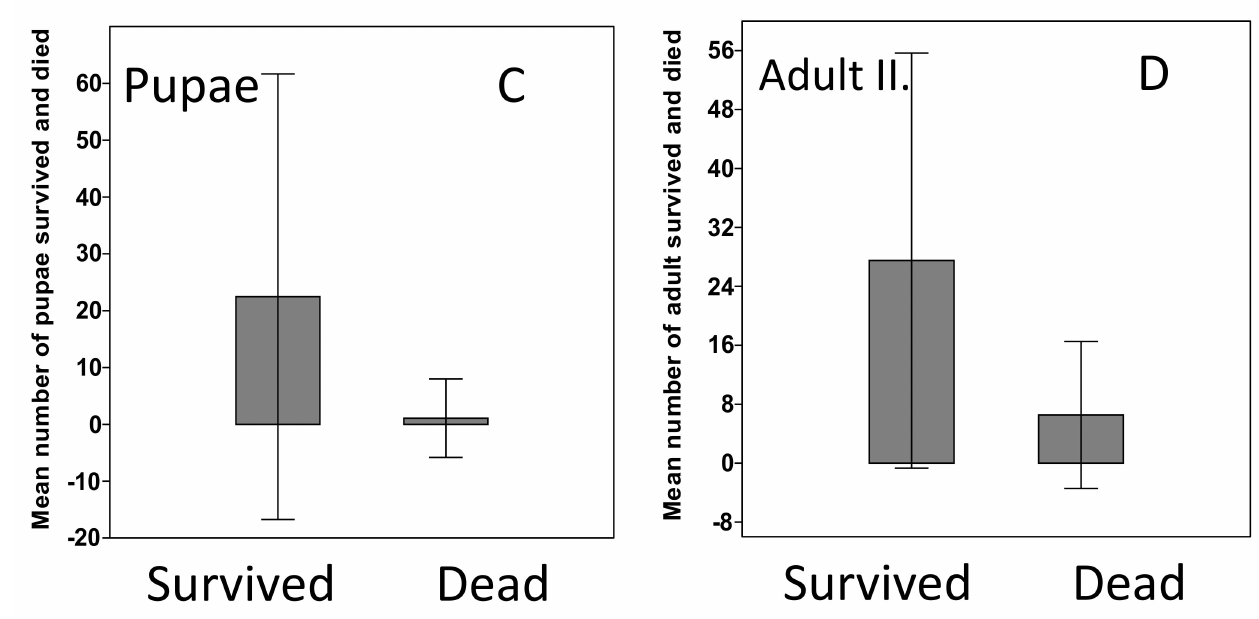
Figure 5. Adult, larval, pupae and next-generation adult survival rate under B. bassiana treatment. A Kruskal–Wallis test followed by a Wilcoxon test were used to compare survival rates. ( A )–Adults from the start of the experiment, ( B )–larval survival, ( C )–Pupae survival, ( D )–Adults from the next